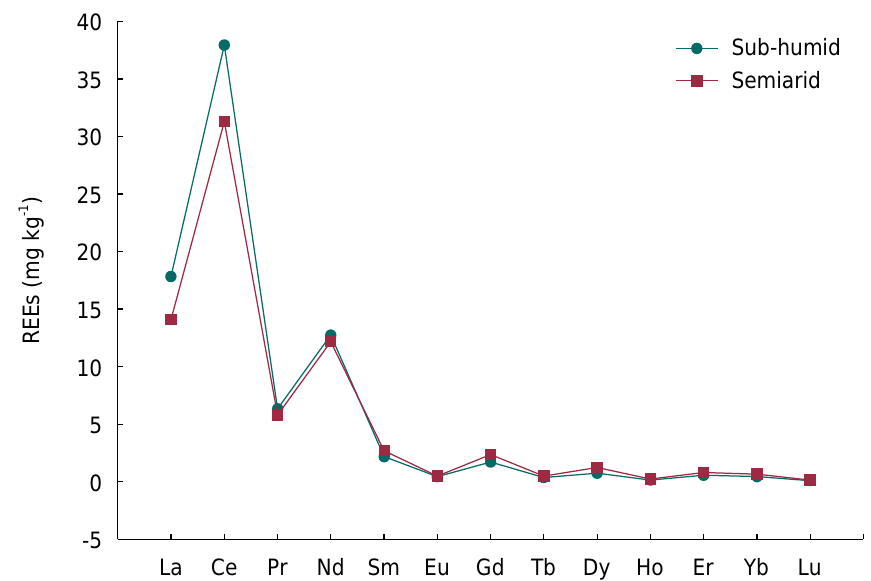
Figure 4. Rare earth elements in soils derived from metamorphic rocks across a climosequence (sub-humid and semi-arid zones) in the state of Rio Grande do Norte, Northeast